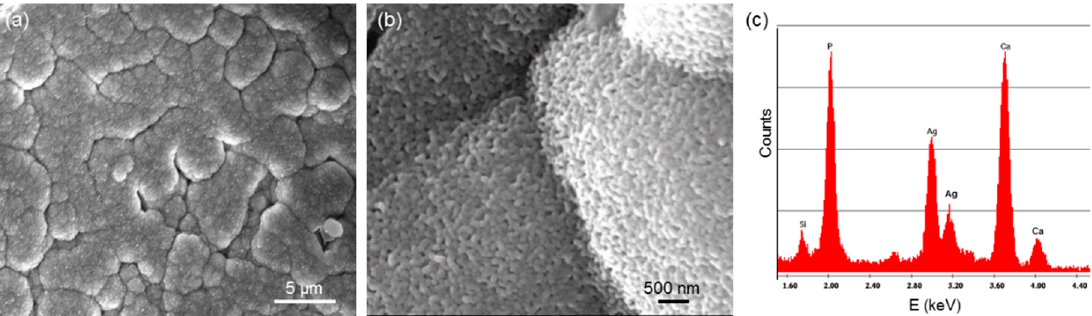
Figure 4. In vitro bioactivity tests carried out on TT-CEL2 samples: ( a,b ) sample surface after soaking for seven days in simulated body fluid (SBF) and ( c ) corresponding energy dispersive spectroscopy (EDS) pattern.